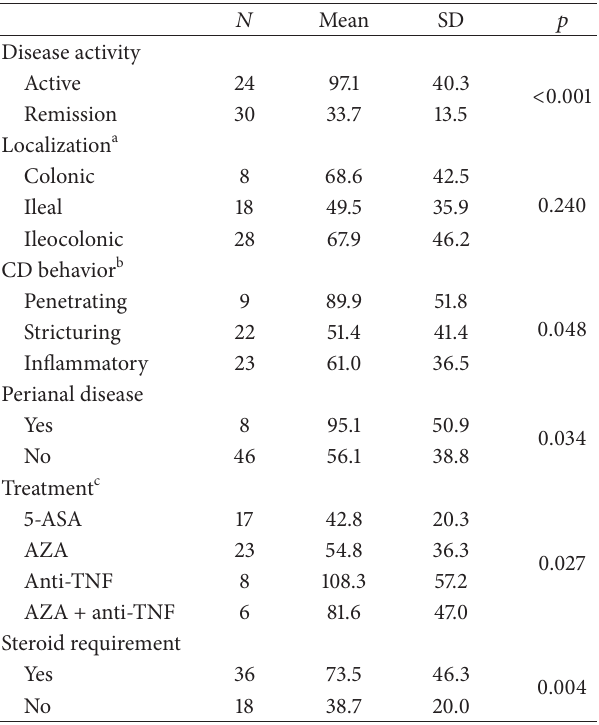
Table 2: The effects of disease characteristics and the treatment methods on serum SDC-1 level.